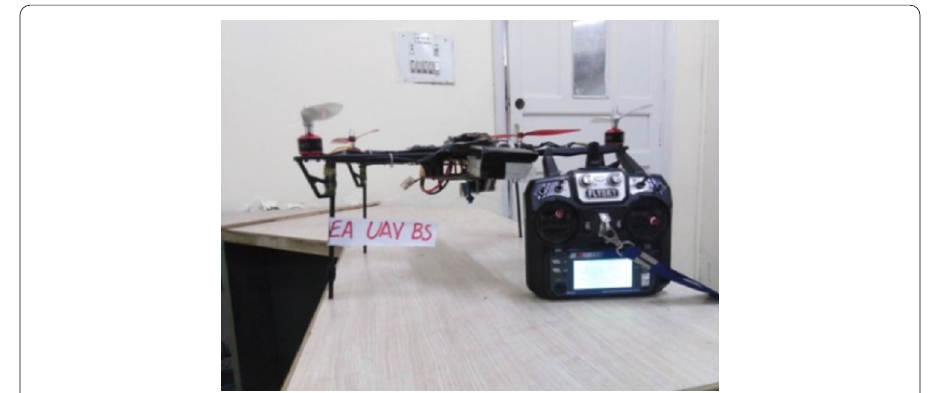
Fig. 4 Side view-UAV